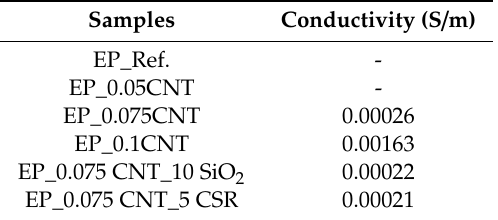
Table 2. Electrical conductivity of di ff erent modified epoxy